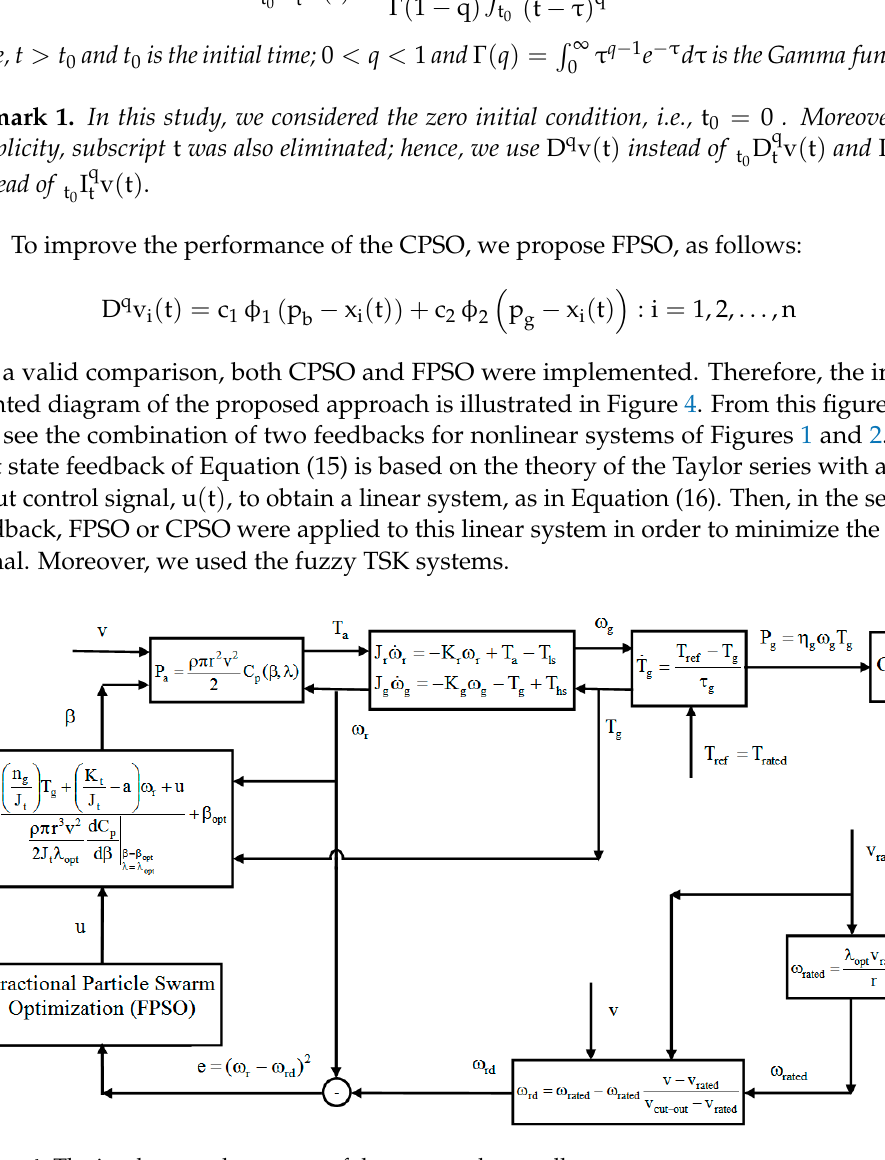
Figure 4. The implemented structure of the proposed controller.